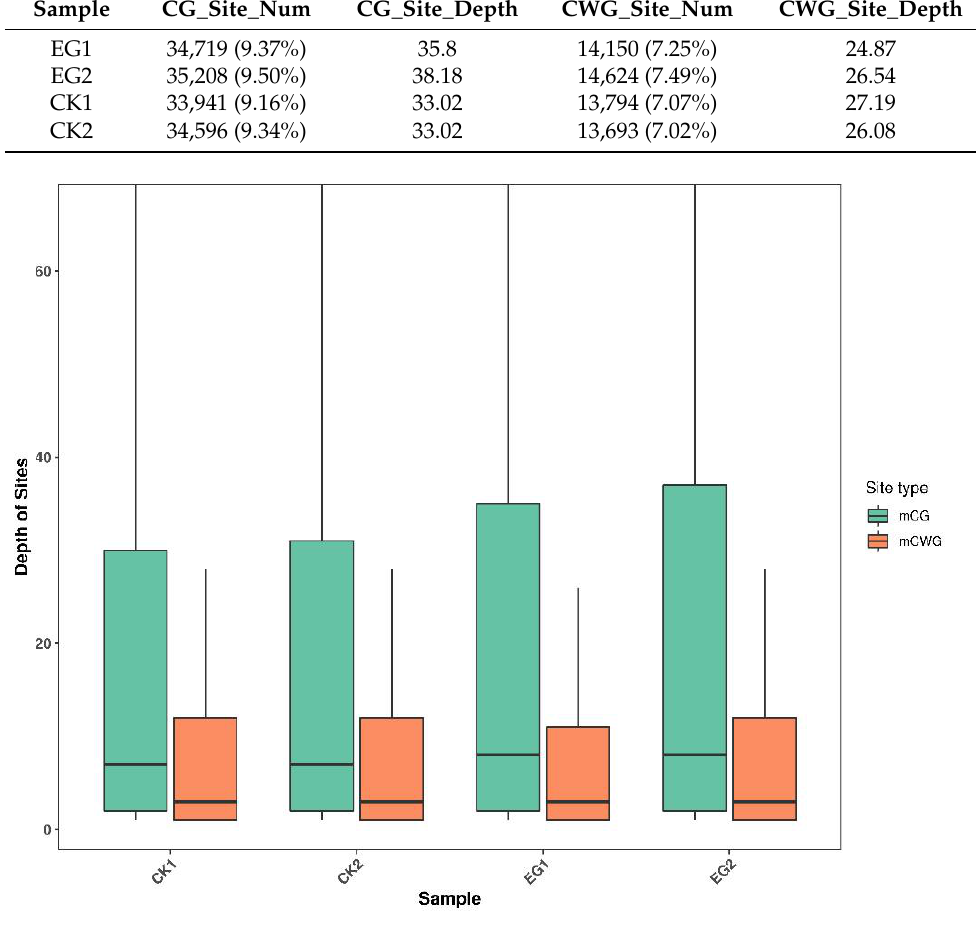
Figure 2. Distribution of MethylRAD sequencing data in mulberry samples. mCG is the methylation at the CG sites; mCWG is the methylation at the CWG sites, where W = A or